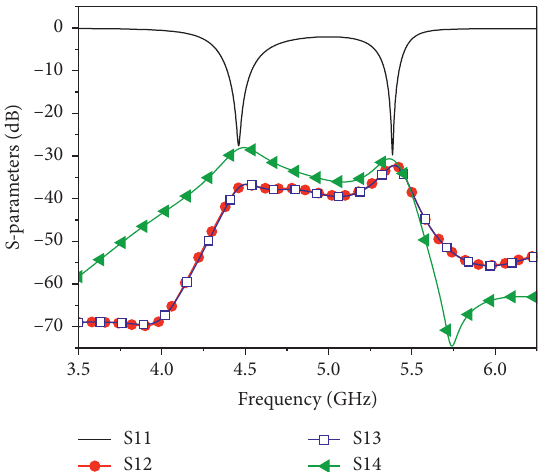
Figure 6: Simulated S-parameters of the four-element dual-band MIMO antenna.